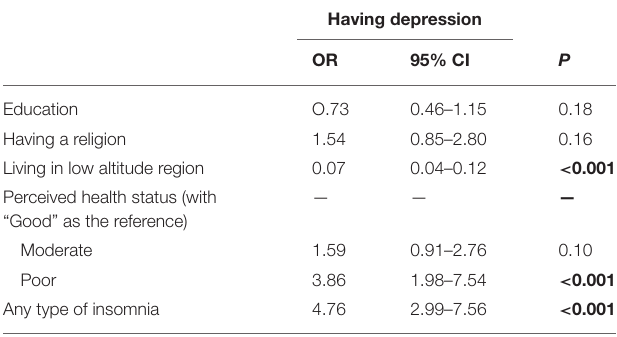
TABLE 3 | Socio-demographic correlates of depression in older adults (by multiple logistic regression